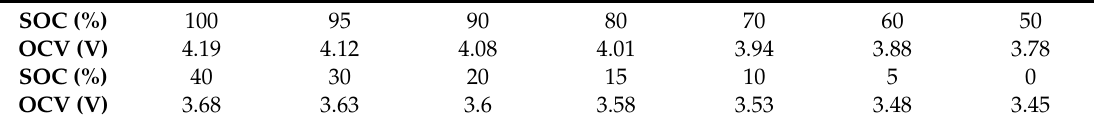
Table 2. Measured OCV at different state of charges (SOCs).